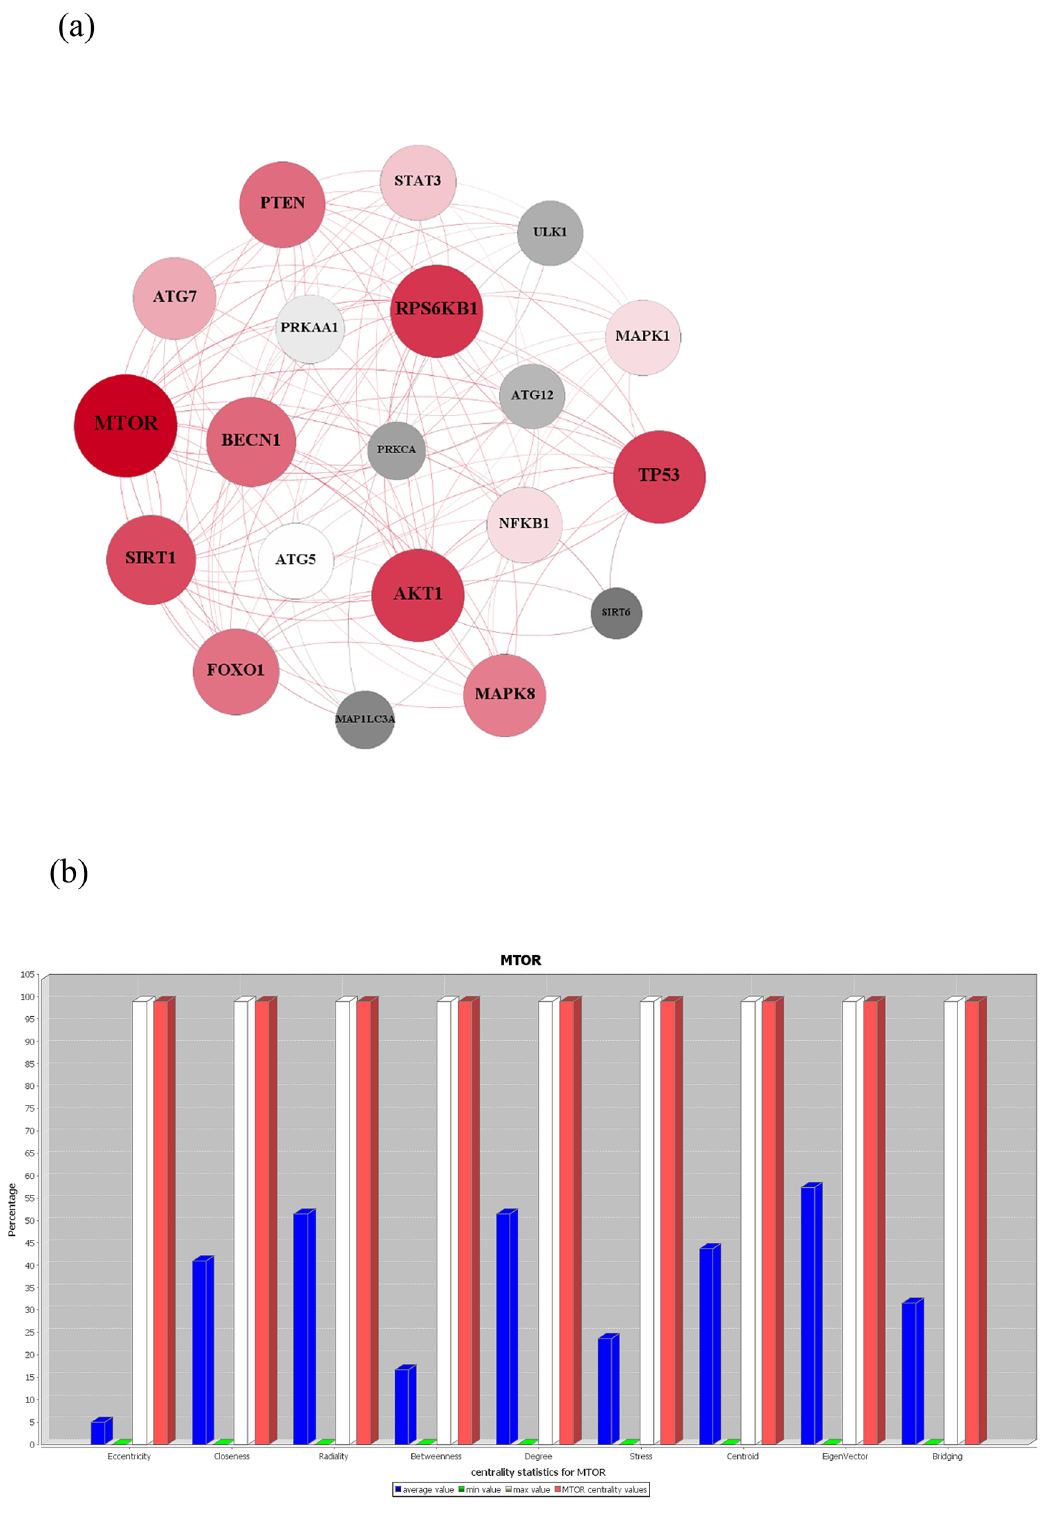
Figure 4. Network analysis of the medicinal plants’ targets. ( a ) Network visualization and analysis by Gephi. The size and the color of nodes represent the degree and eigenvector, respectively. ( b ) Network analysis of the medicinal plants’ targets. mTOR has a crucial role in this network since it has high centralities values for all the computed